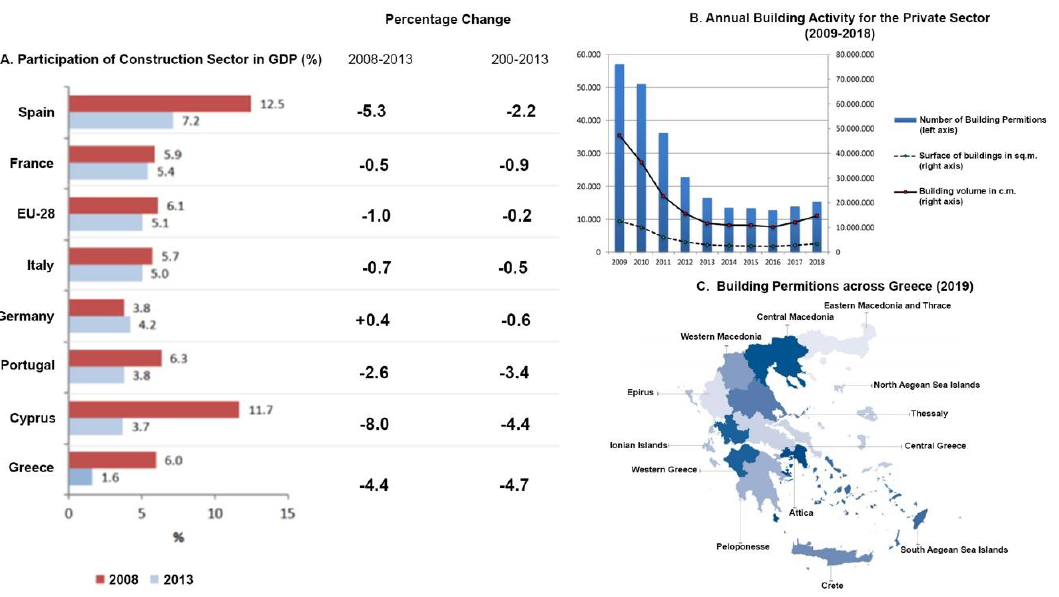
Figure 2. Statistics concerning building activity in Greece. Source: [36,37].